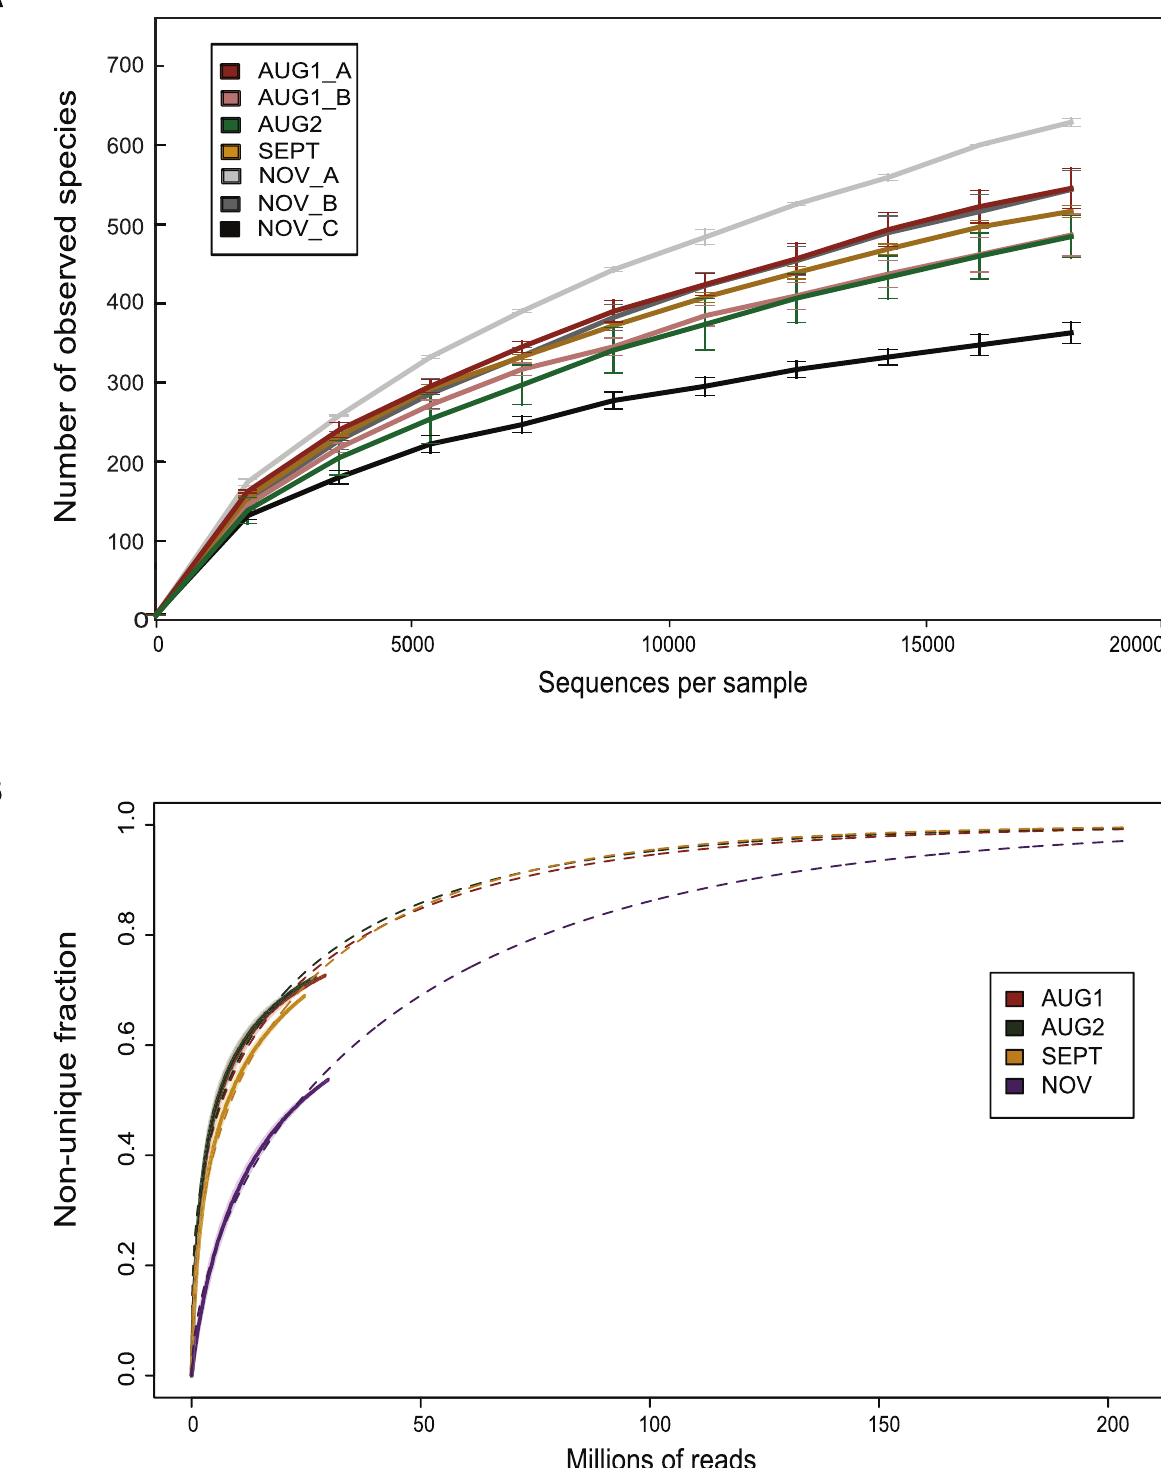
Figure 1. Diversity estimates for the four Lake Lanier timepoints . A) Alpha diversity based on observed species (97% OTUs) from 16S amplicons for each of the nine samples. Error bars represent the variation observed among duplicate sequencing runs. B) Redundancy curves of the metagenomes of the four timepoints using (see Methods for details). The curves show that NOV is a more diverse sample, e.g., with the same sequencing effort it results in a lower coverage.